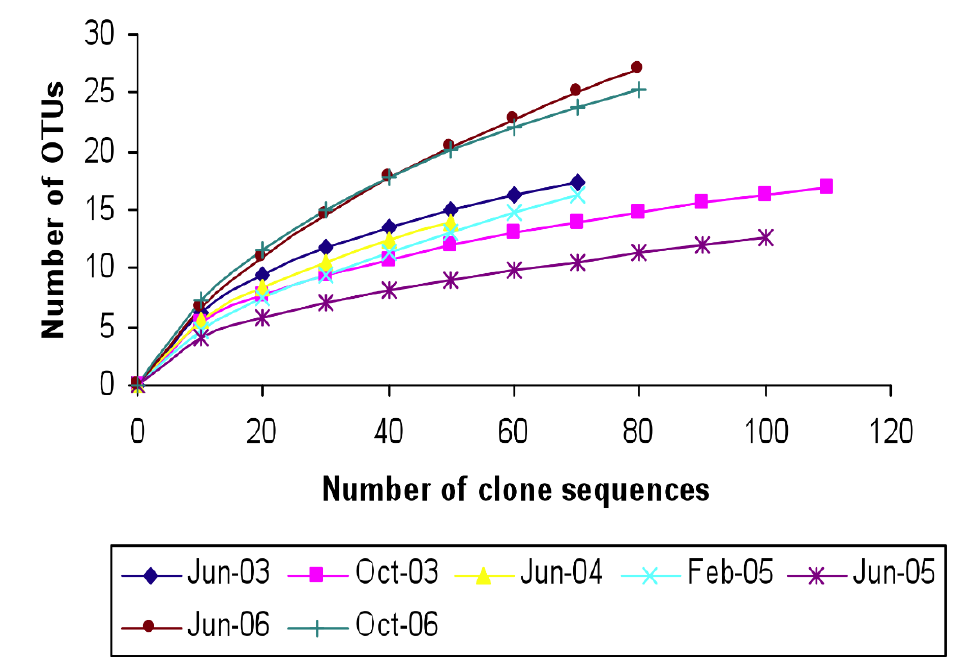
Figure 4. Rarefaction curves (95% similarity cut off) indicating community taxon richness based on 16S rRNA gene sequences of archaea obtained from the north arm of Great Salt